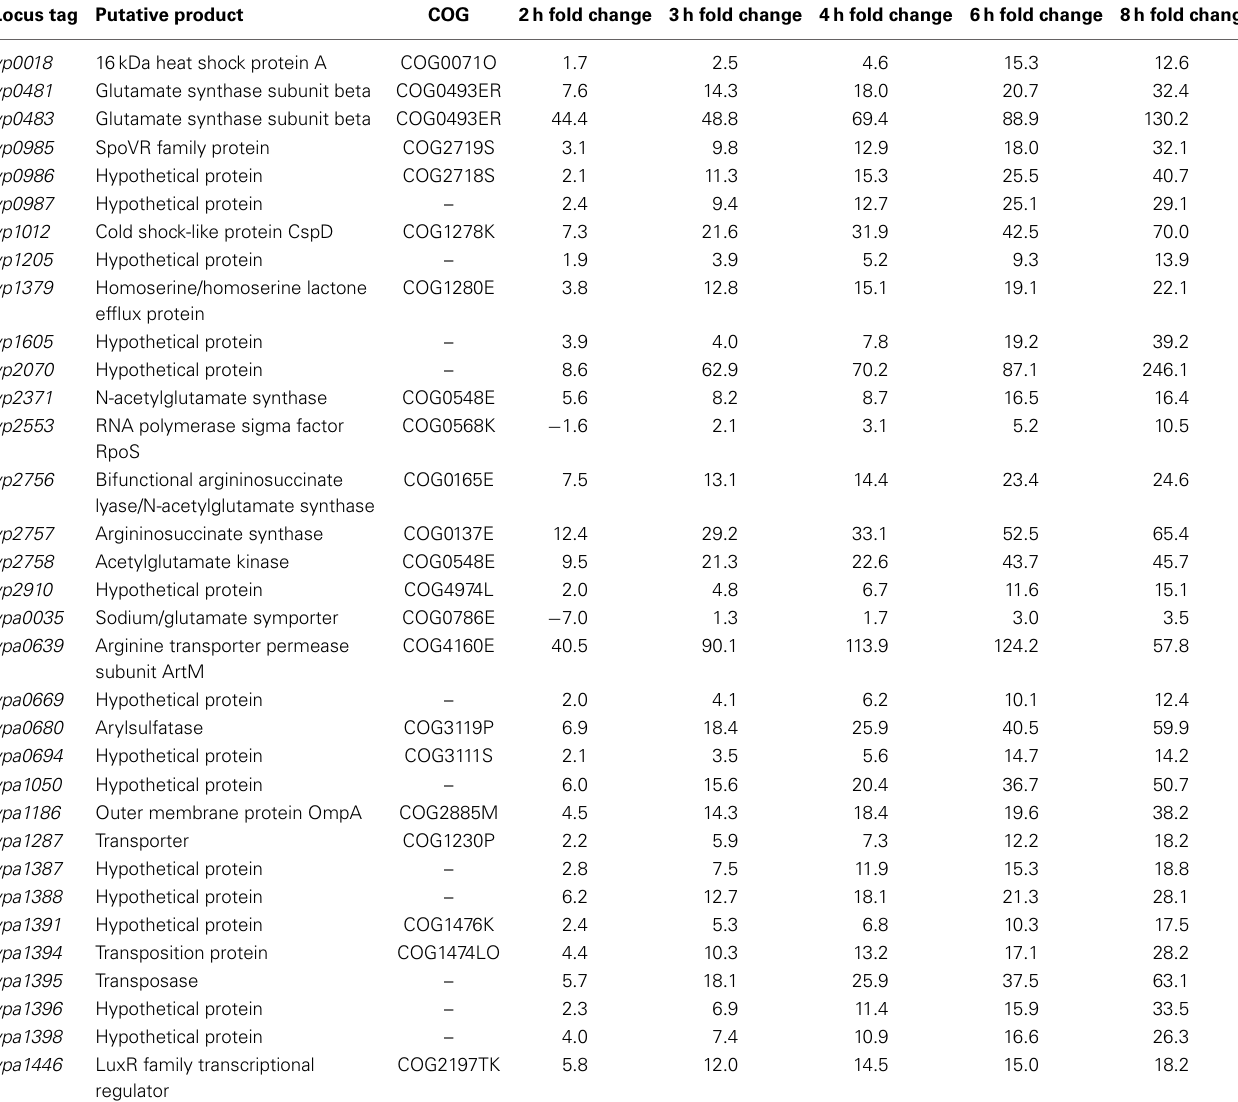
Table 2 | Genes showing upregulation over the course of HeLa cell infection compared to 0h (pre-infection), defined as increasing fold change from 3–6h post-infection, ≥ 10-fold increase between 2 and 8h post-infection, and 8h fold change > 0 ( P < 0 . 05 ) * . Locus tag Putative